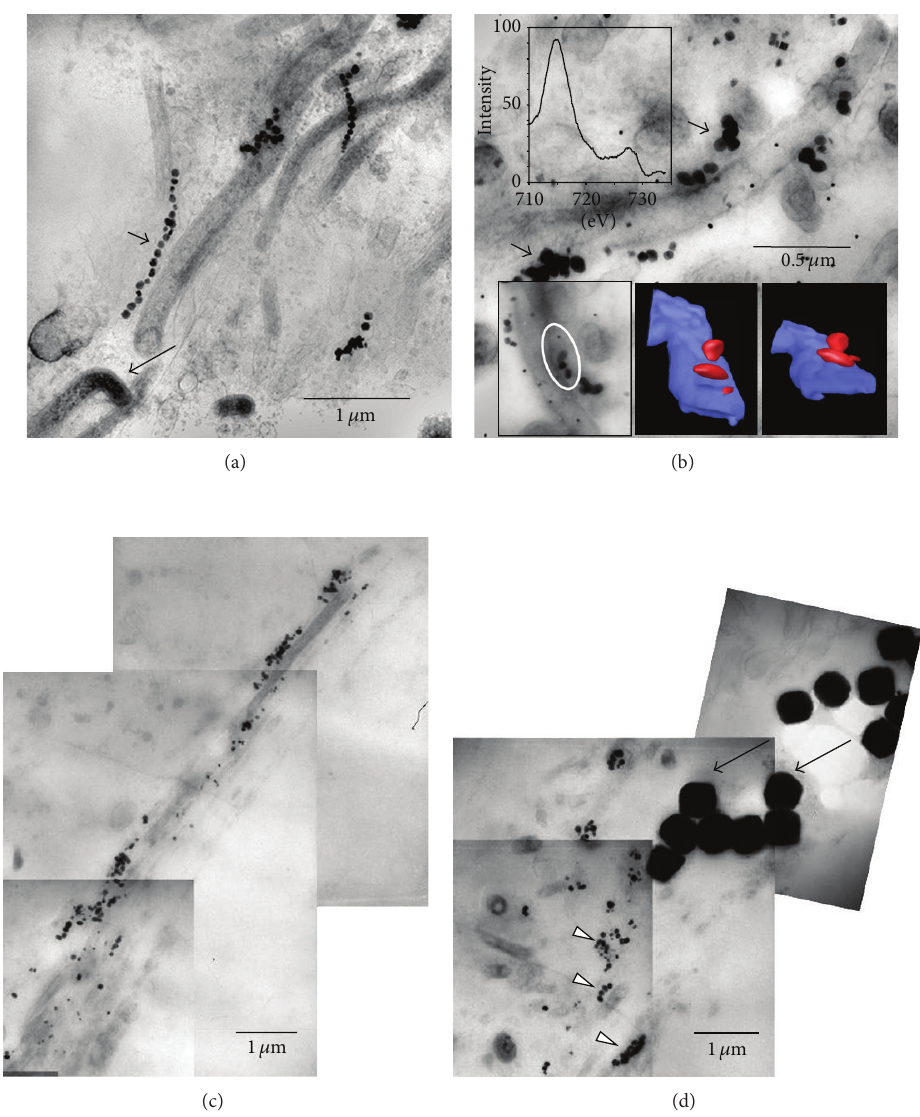
Figure 5: Extracellular magnetosome-like features. (a) Extracellular magnetosome chains (short arrow) bound to filamentous cell envelopes. Occasionally, also intact organisms, filled with dark cytoplasm, are visible (long arrow). (b) Particles (arrows), double in size of magnetosomes close or attached to filaments. The EELS spectrum (upper left inset) shows the energy loss at the Fe L2/L3 edges. The lower right insets show a tomogram of a small section (encircled) as depicted in the lower left inset (blue: cell envelope, red: particles). The small dots represent randomly distributed colloidal gold particles (no markers) necessary for image alignment of the tilted sections. (c) Overview image showing aggregates of the particles adjacent to filamentous envelopes. (d) Aggregates of particles (arrowheads) and typical microcrystals from framboidal pyrite